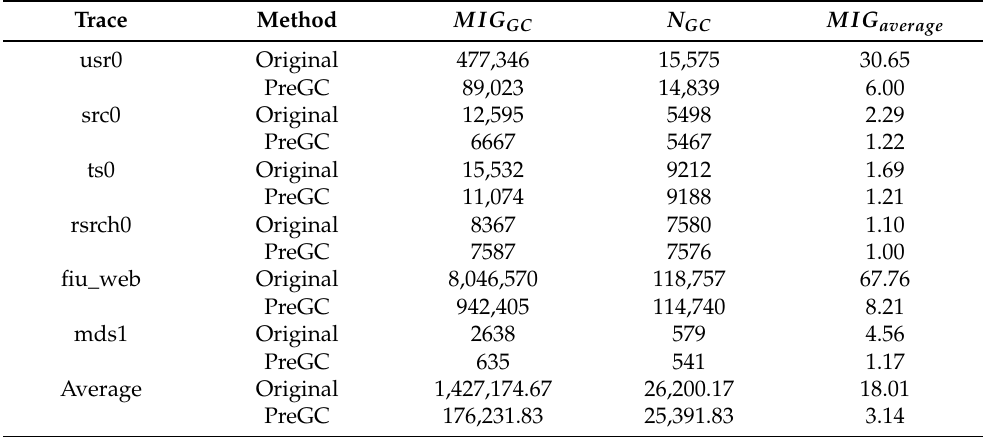
Table 5. Statistics of six real-world